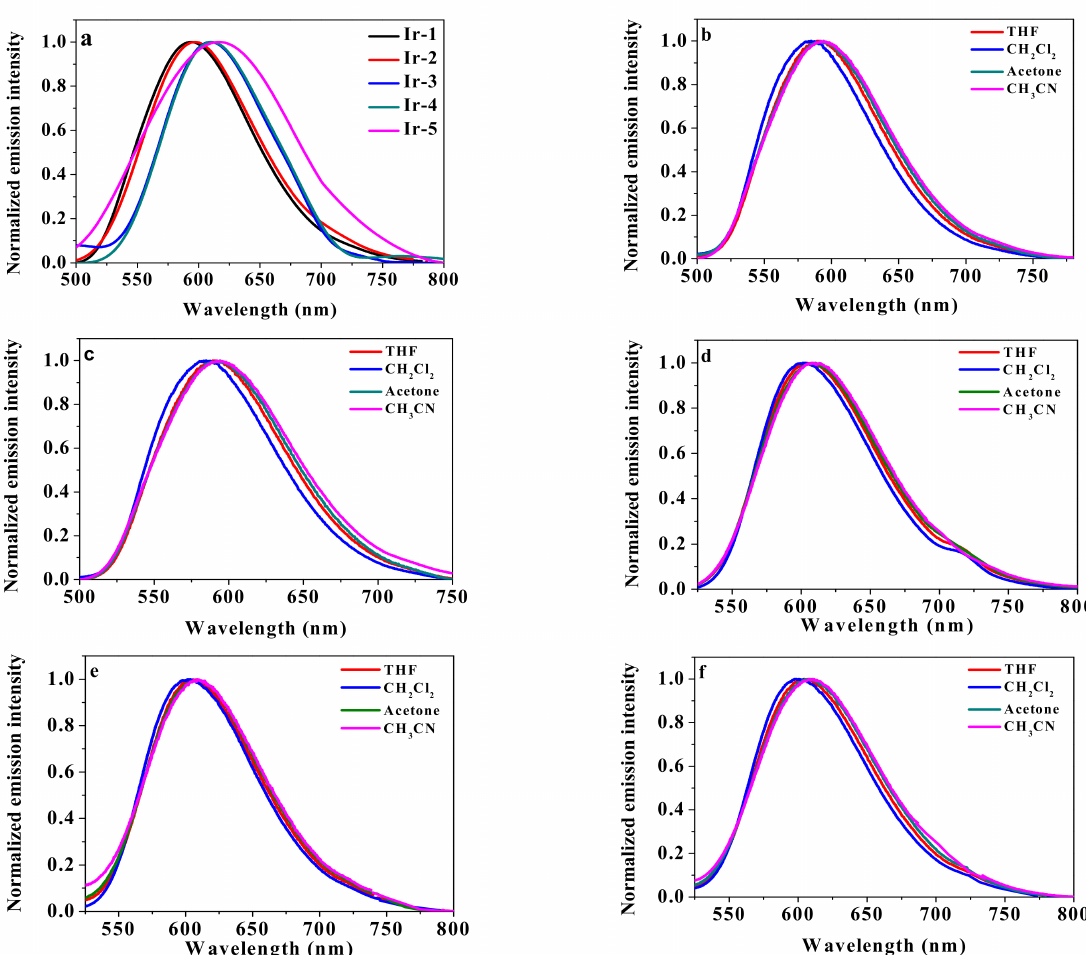
Figure 2. ( a ) Normalized emission spectra of complexes Ir-1 – Ir-5 in CH 3 CN ( c = 1 × 10 − 5 mol/L). ( b – f ) Normalized emission spectra of complexes Ir-1–Ir-5 in different